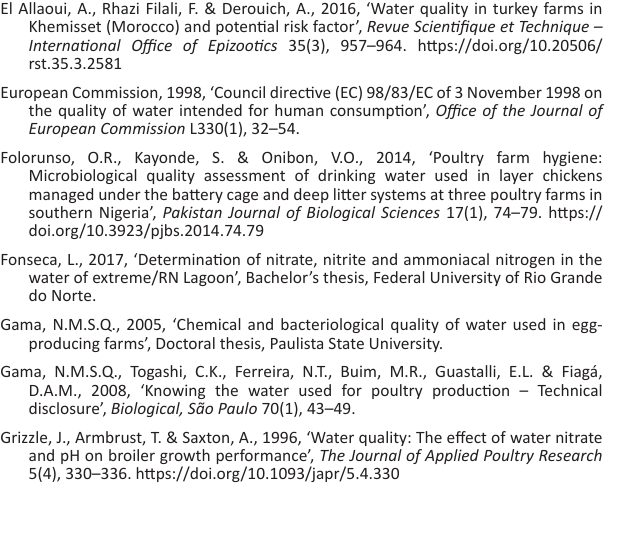
Tabler, G.T., 2003, ‘Water intake: A good measure of broiler performance’, Avian Advise 5(3), 7–9. Travel, A., Bouvarel, I., Chevalier, D. & Fulbert, L., 2007, ‘Un bon démarrage (0–42 jours) permet de limiter l’apparition d’entérite chez les dindonneaux’, Journées